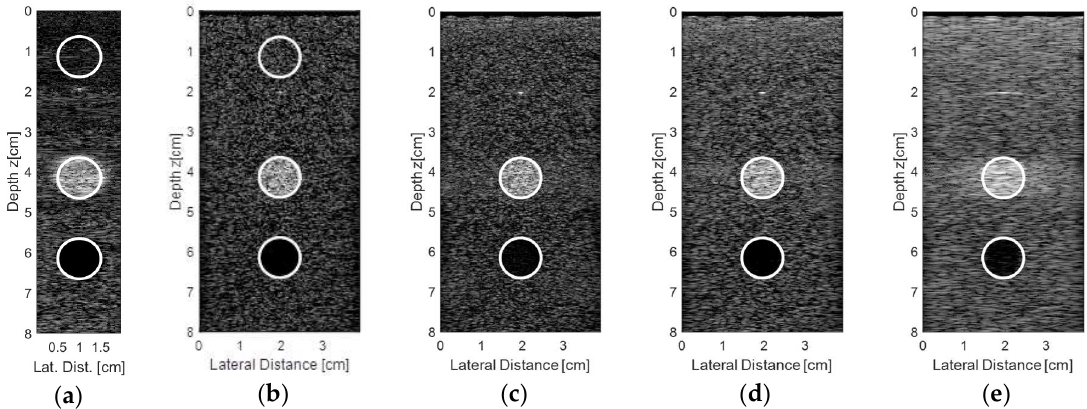
Figure 12. Contrast analysis for the solid and cyst targets and the background area at a 1 cm depth, as shown in ( a , b ), with the transducer excited using the DAS method ( a ) and with plane wave in an angle range of −1.5° to + 1.5°, step angles of 0.5°, and receiving the data with ( b ) 128, ( c ) 65, ( d ) 44, and ( e ) 23 elements.